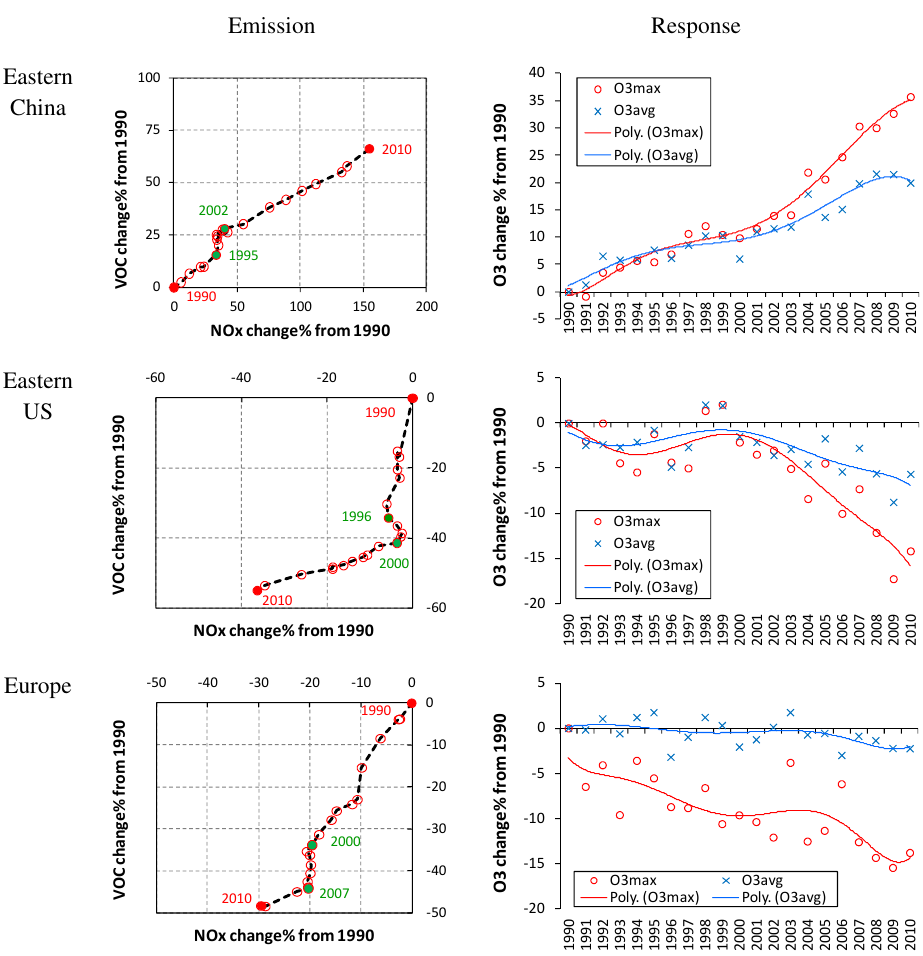
Figure 10. Changes in O 3 chemistry from modeling